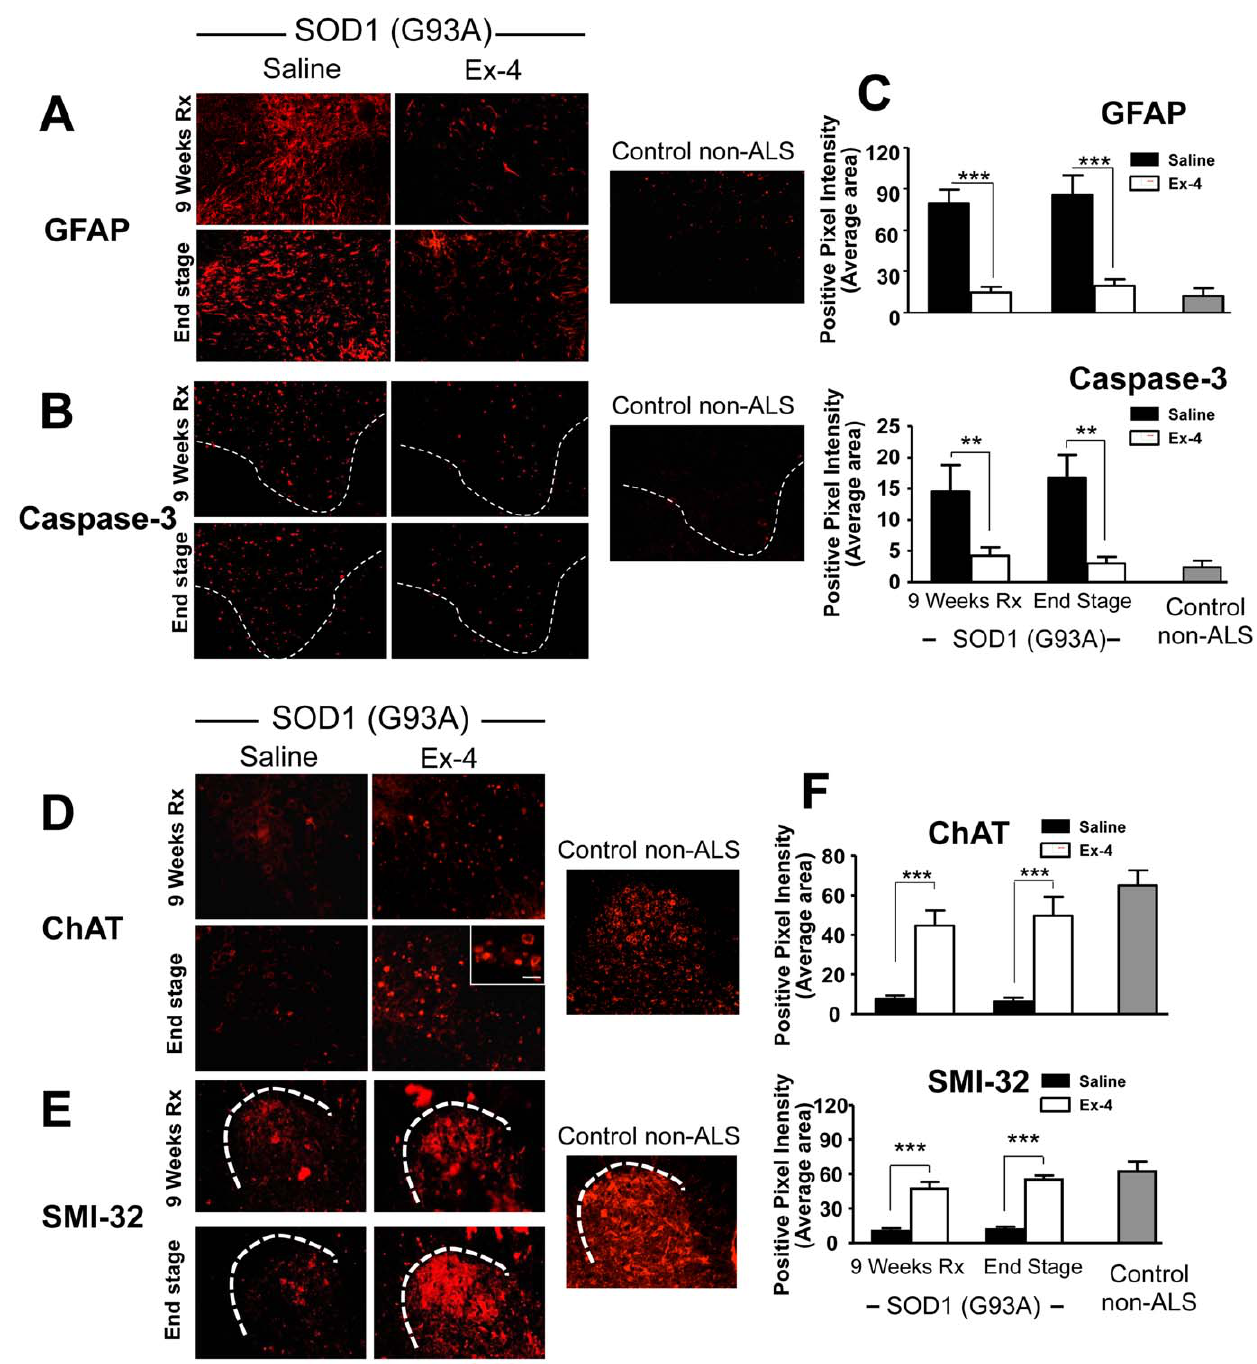
Figure 7. Ex-4 treatment modified cell type specific markers of spinal cord in SOD1 (G93A) mice towards levels present in control non-ALS WT mice. ( A & C ) Glial fibrillary acidic protein (GFAP) is a glial cell marker and is usually up regulated under neurodegenerative conditions [86]. Ex-4 treatment significantly reduced GFAP immunostaining in SOD1 (G93A) mice spinal cord. ( B & C ) Caspase-3 is an apoptotic marker. There are 3- to 4-fold less numerous activated caspase-3 neurons in Ex-4-treated G93A SOD1 mice lumbar spinal cord sections. ( D & F ) Choline acetyl transferase (ChAT) is a cholinergic neuron marker. Immunostaining with specific ChAT antibody shows significantly greater ChAT immunointensity in Ex-4-treated SOD1 (G93A) mice. ( E & F ) SMI-32 is a neurofilament marker that interacts with a nonphosphorylated epitope in neurofilament H of most mammalian species. There is greater SMI-32 immunointensity in SOD1 (G93A) mice (n=5, ** p , 0.01, *** p , 0.001). For all investigated markers, Ex-4 treatment of SOD1 (G93A) mice substantially ameliorated the dramatic differences evident between vehicle SOD1 (G93A) and control non-ALS WT mice (C & F).